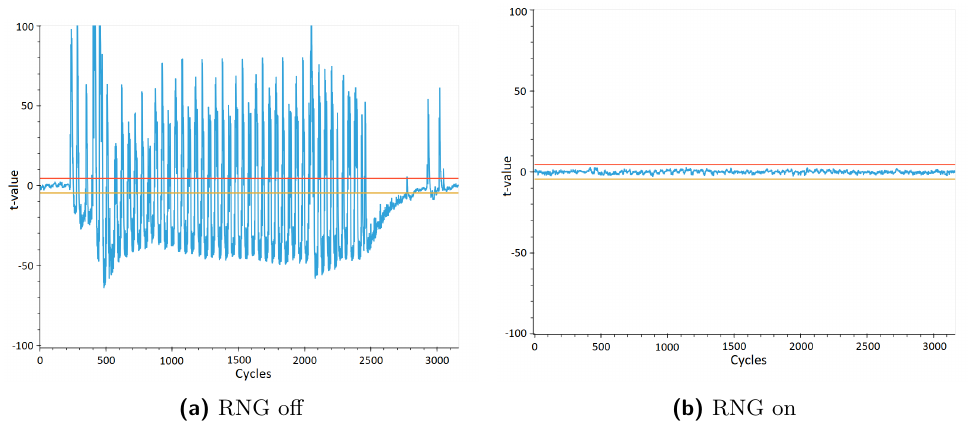
Figure 1: t -test results on a ChipWhisperer-Lite board, with 10 000